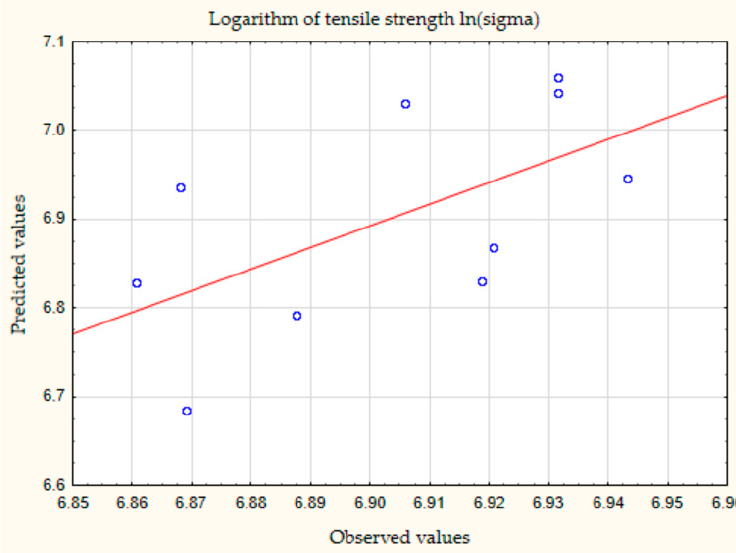
Figure 4. The observed and predicted yield strength values.